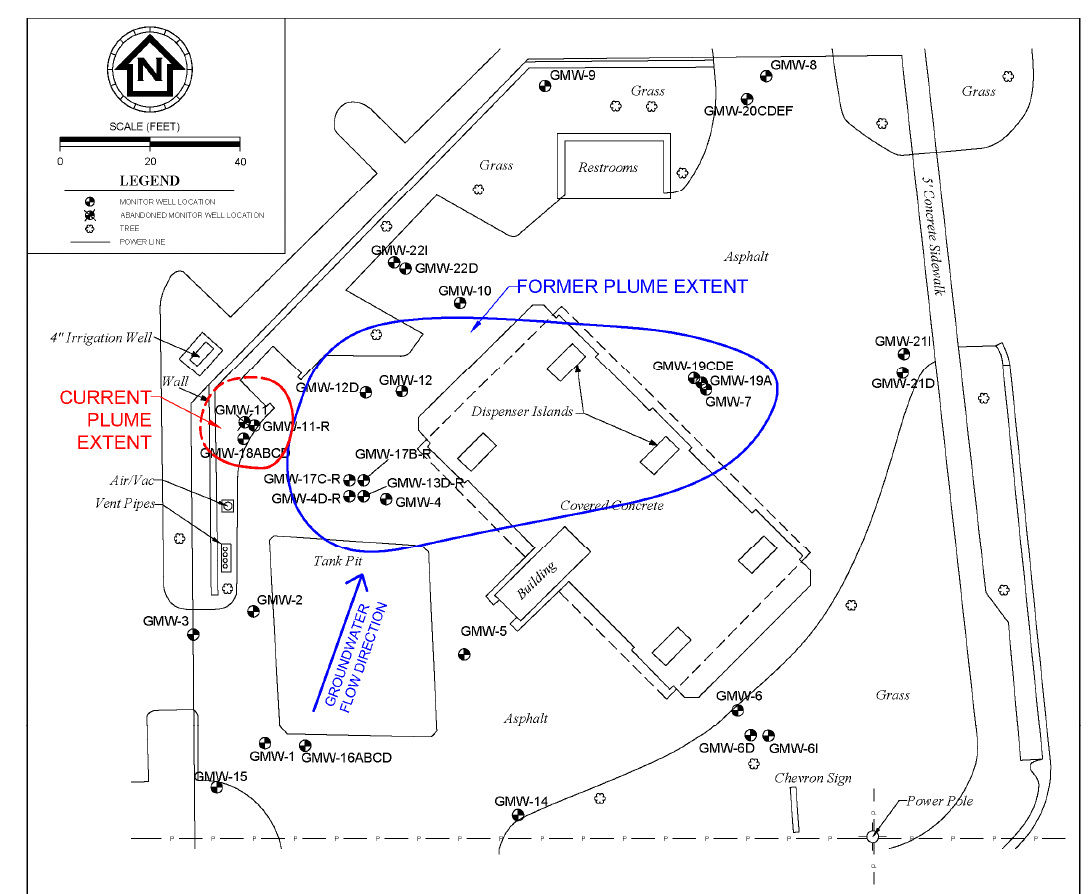
Figure 6. Site plan with estimated groundwater flow direction and plume extents.